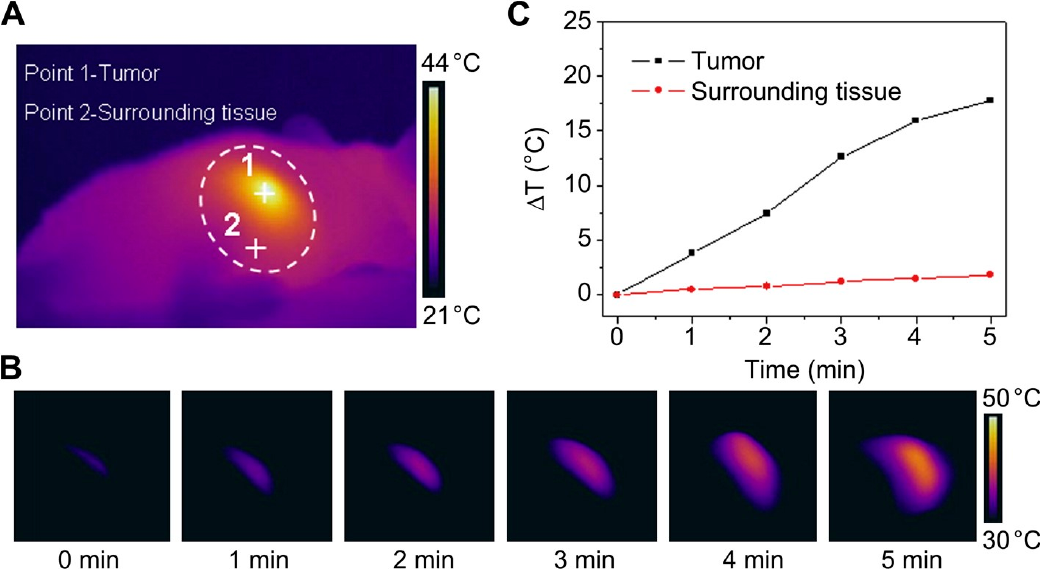
Figure 1. An example of polyaniline ‐ based nanoparticles for photothermal therapy. ( A ) Photothermal images of a mouse after intratumoral injection of F127 ‐ modified polyaniline nanoparticles (F ‐ PANPs) (1 mg/mL) with an 808 nm laser (0.5 W cm − 2 , 3 min). When irradiated within the white circle area, the tumor (Point 1) and the surrounding tissue (Point 2) were heated. ( B ) Photothermal images of the tumor obtained at different time points. The scale bar indicates the temperature difference between 30 °C and 50 °C. ( C ) The relationship between sample temperature and laser illumination time is shown in (A). Reproduced from [24] with permission, copyright Elsevier, 2013.